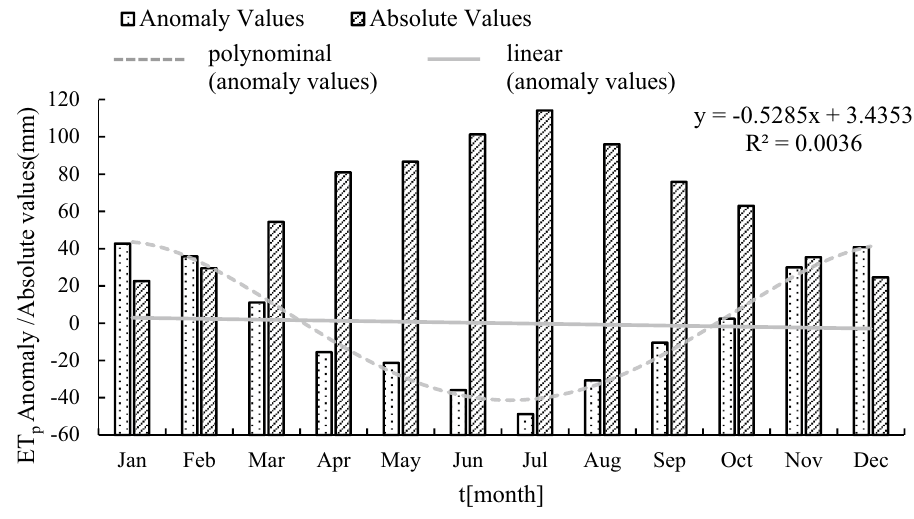
Figure 2. The anomaly and absolute value of ET p in Hancang River Basin.